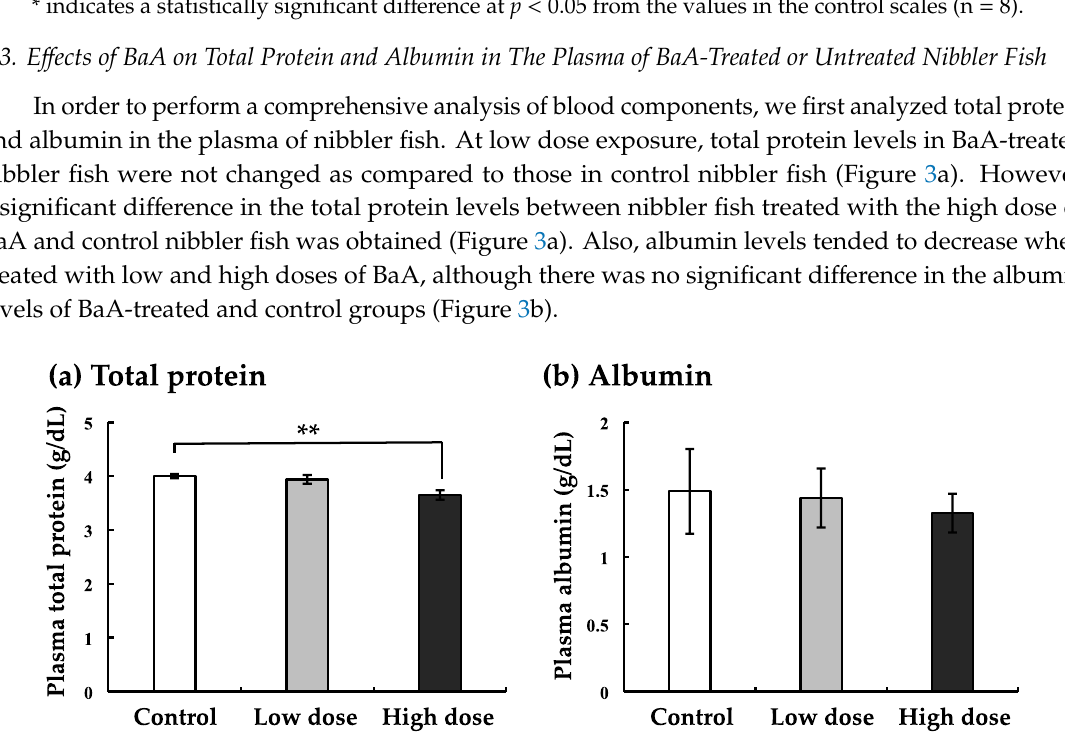
Figure 3. E ff ect of BaA on total protein ( a ) and albumin ( b ) in the plasma of BaA-treated or untreated nibbler fish. BaA (1 or 10 ng / g body weight) was injected intraperitoneally (four times) into nibbler fish for 10 days during breeding. Thereafter, total protein and albumin were examined in the control and experimental groups. ** indicates a statistically significant di ff erence at p < 0.01 from the values in the control scales (n = 8). The detection limits of total protein and albumin were 1.0 and 1.0 g / dL, respectively.